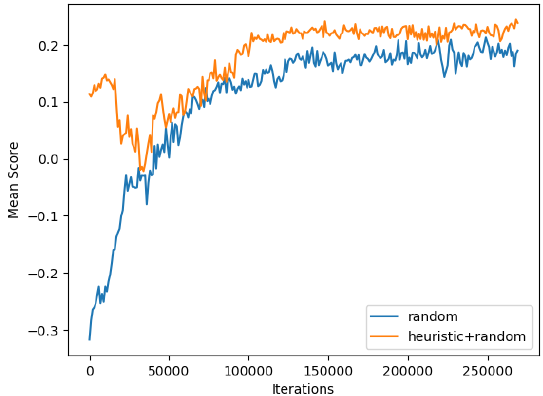
Figure 8. The score curve of 2D Q-Network.